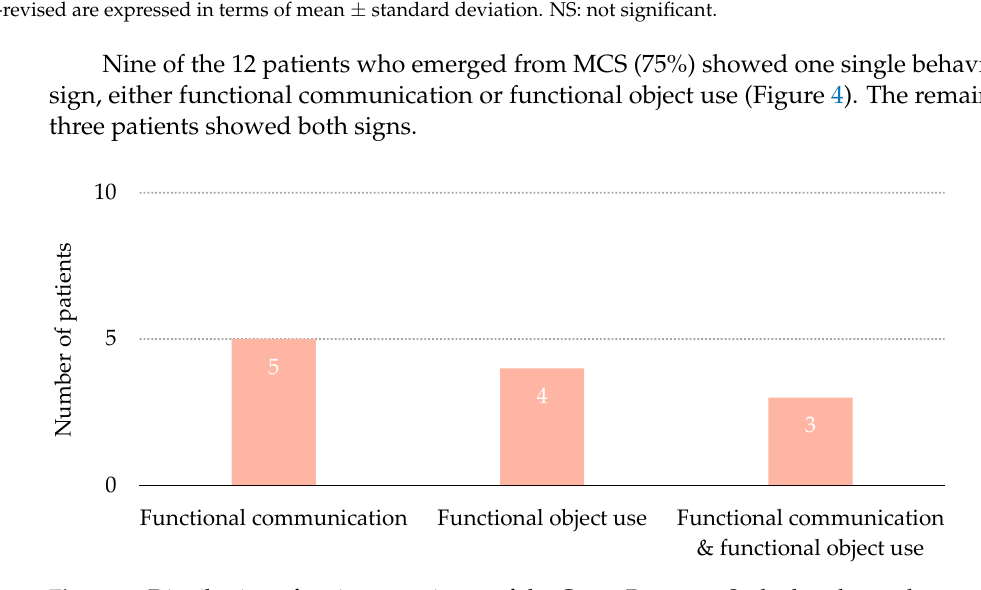
Figure 4. Distribution of patients per items of the Coma Recovery Scale that denoted emergence from Minimally Conscious State. Table 5. Parameters and validation metrics of the predictive model of emergence from Minimally Conscious State. Multivariable Logistic Regression Model